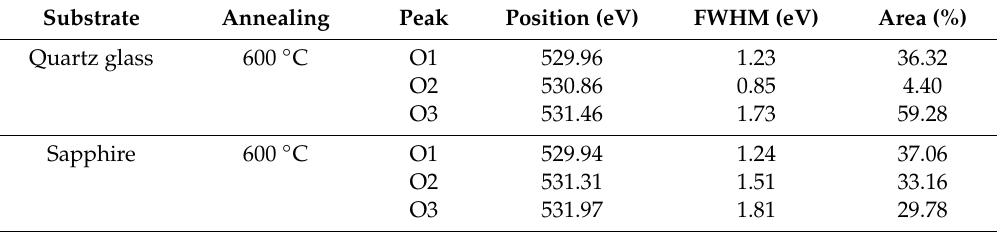
Table 2. Oxygen-related XPS characteristic parameters for the as-grown ZnO thin films on quartz glass and sapphire (001) substrates annealed at 600 ◦ C for 1 h.